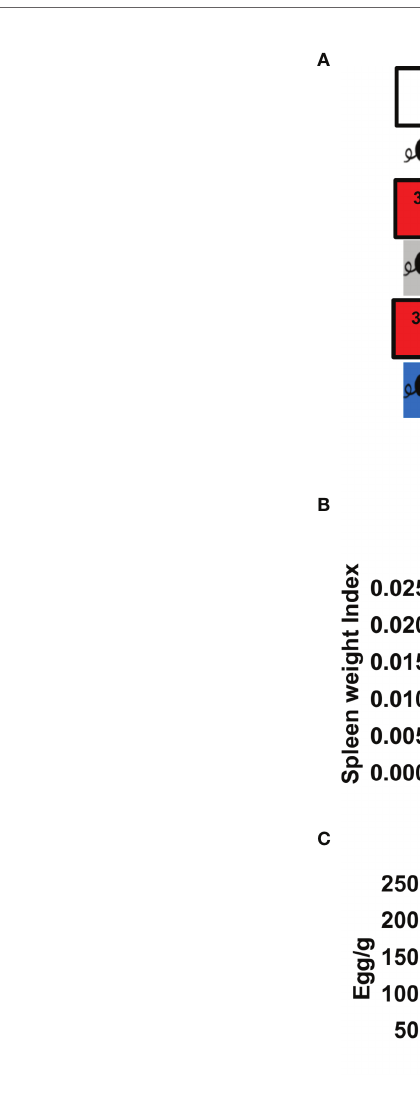
FIGURE 5 | Abridged study design of Infection-PZQ treatment combo. (A) study design. Outcome measure = Egg burdens and rate of associated organomegaly in animals. C57BL/6 (>8 weeks old) mice were infected percutaneously with 35 S. mansoni cercariae (or exposed to cercariae water for the naïve group) and treated 14 weeks later either with racemic PZQ (or carrier solution for the infected and untreated group) by administration at 400mg/kg twice within a week by oral gavage. Two weeks following the end of anti-parasitic treatment with PZQ, mice were sacri fi ced and, speci fi cally, biopsies of spleen, liver and blood were done for laboratory analyses of egg burdens, Antibody ELISA, Cytokine ELISA, Histology and Flow cytometry. (B) Organ weights (liver and spleen indexes as ratio of organ to body weights). (C) Liver egg burden. Experiments were conducted in two independent runs with 5-7 mice per group (Experiment 1: naïve group = 7 mice; infected group = 6 mice; infected and treated group = 7 mice; Experiment 2: naïve group=5 mice; infected group = 5 mice; infected and treated group = 7 mice). A total of 37 mice were used for this scheme. Data are expressed as mean ± SEM; NS = p > 0.05; *= p < 0.05; **= p < 0.01; ***=, p < 0.001 as determined by Kruskal-Wallis test with correction for multiple comparisons by Dunn ’ s